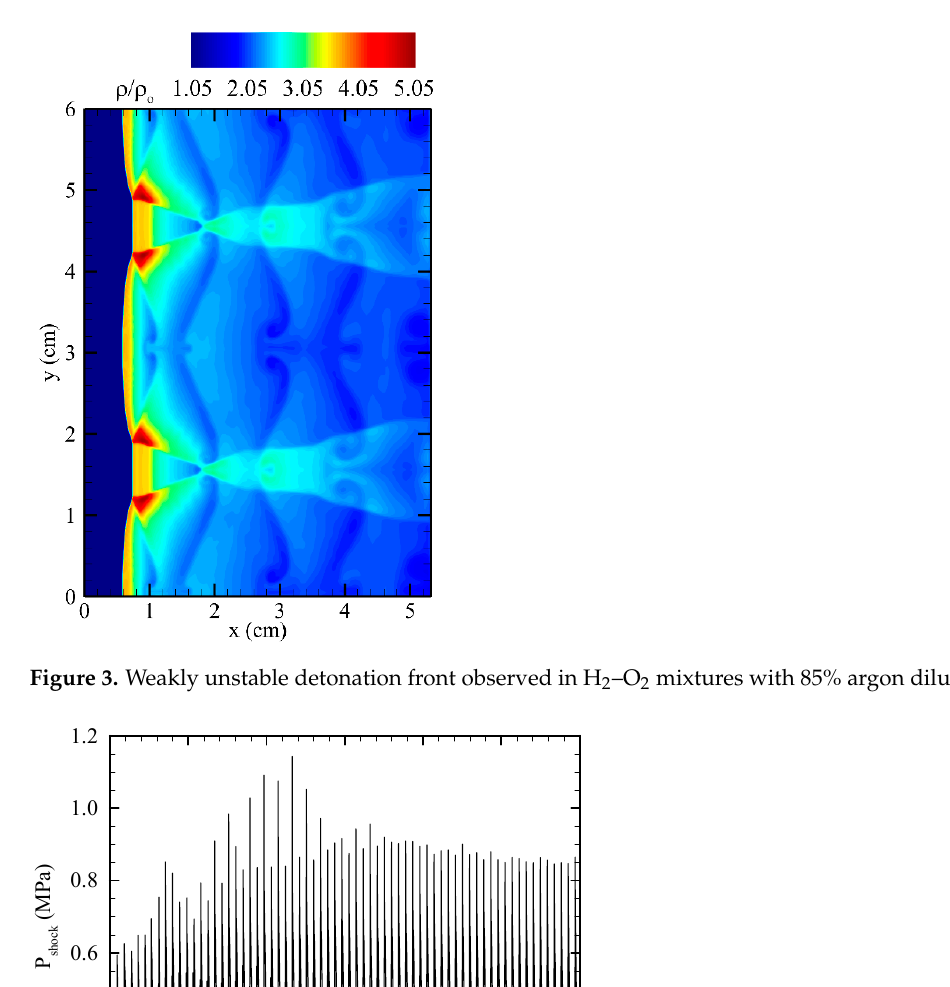
Figure 2. Grid refinement study using post shock pressure (number of grid points within the induc- tion zone; Case 01–15 grid points, Case 02–30 grid points).